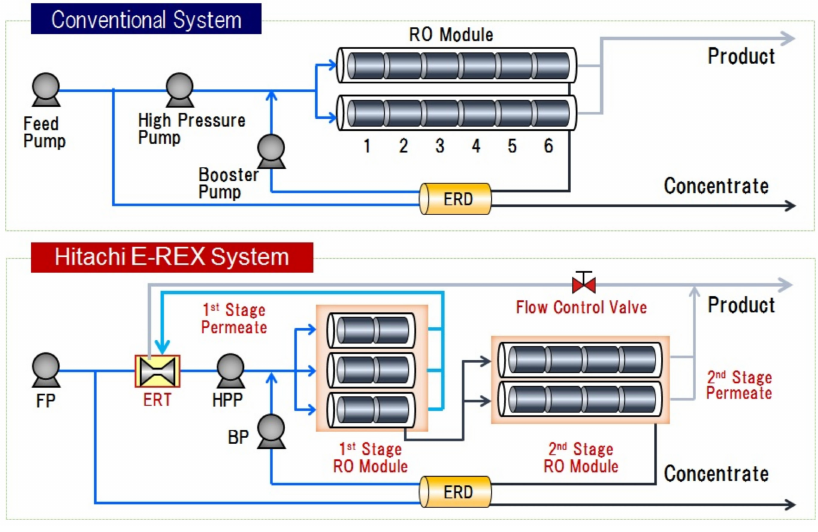
Figure 17. High recovery—Low fouling RO design configuration